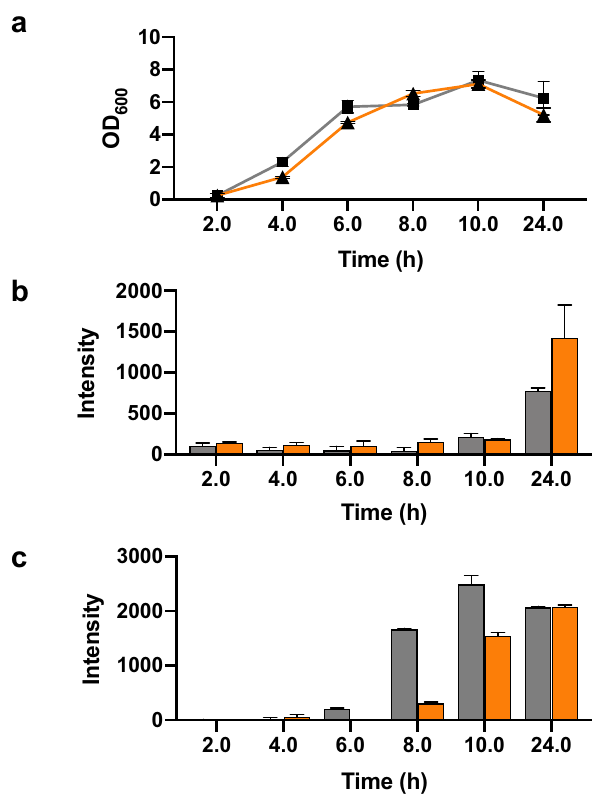
Figure 9. OsmY-RFP expression in E. coli BL21(DE3). Cells were cultivated in 20 mL of 2xTY auto-induction media at 37 °C using 1:100 dilution of inoculum. The supernatant and cells from 20 µL culture were used for fluorescence measurement using E x = 584 nm and E m = 607 nm. ( a ) Growth curve of the culture. ( b ) Fluorescence intensity of the spent medium. ( c ) Fluorescence intensity of the cells. The lines and bars of different variants are represented using different colours; OsmY(WT)-RFP—grey and OsmY(M3)-RFP—orange.